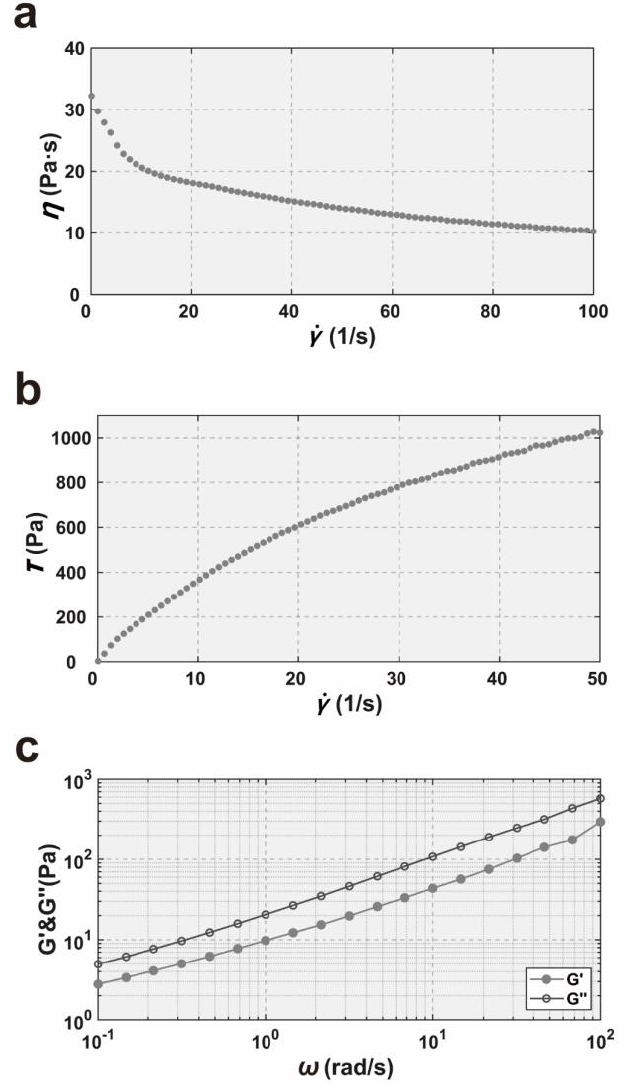
Figure 2. ( a ) Apparent steady-state viscosity η as a function of shear strain rate. ( b ) Shear stress as a function of shear strain rate. ( c ) Storage modulus G ′ and loss modulus G ″ as a function of angular frequency ω .